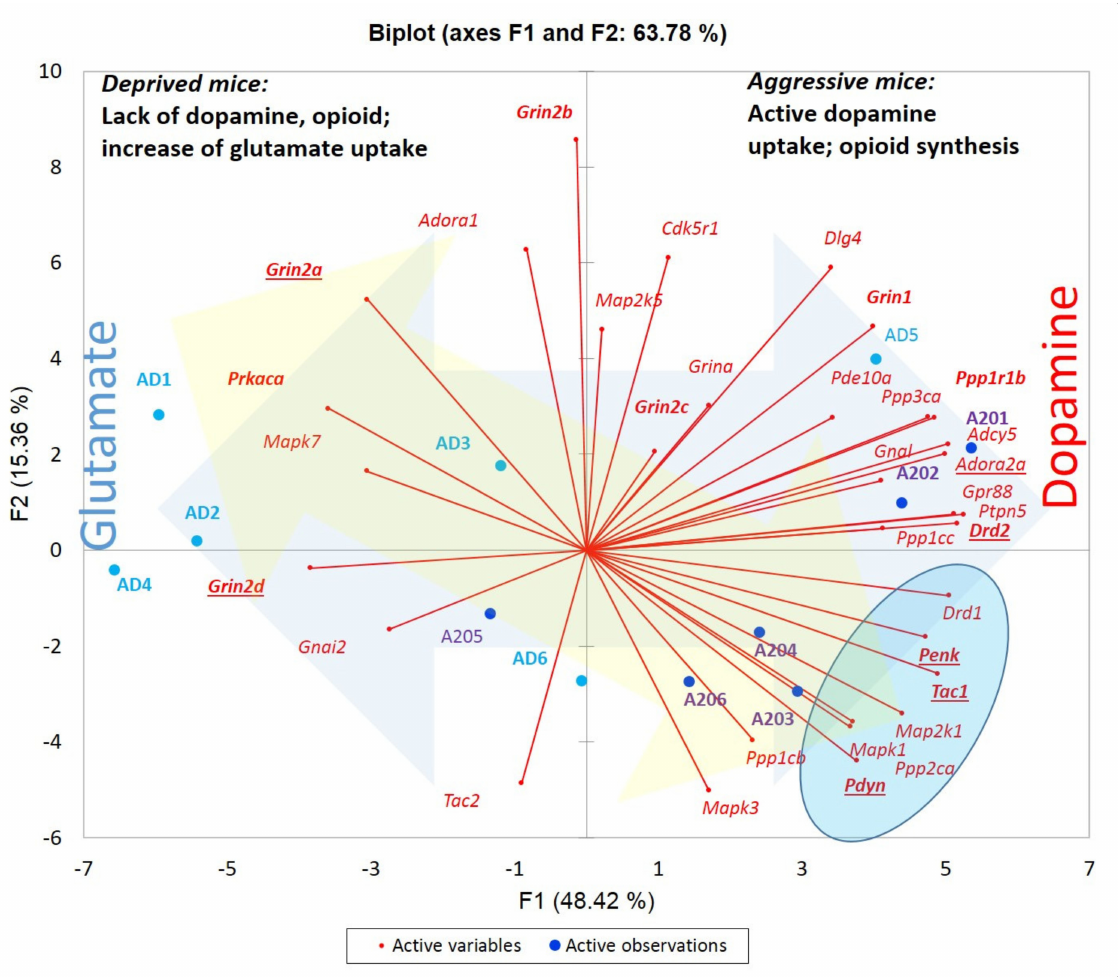
Figure 13. PCA plot based on 33 specific cAMP-mediated balanced gene subset compiled in (Babenko et al., 2020) featuring A20 and AD groups. Marker gene set is shown in bold. Blue-shaded arrow signifies dopamine vs. glutamate uptake gradient. Yellow-shaded arrow signifies D1 passive/active states phasing [11]. Blue-shaded oval underlines opioid synthesis ( Penk, Pdyn). H0: random distri- bution of 5-fold AD sample with only 1 alien species in a plot; left half is p -value < 0.016 (binomial distribution). Blue dots are AD samples; dark blue dots are aggressive samples. Underlined gene names indicate